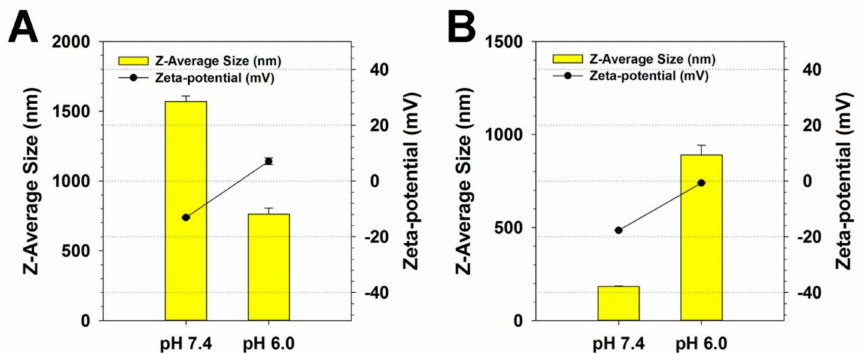
Figure 4. Z-average sizes and zeta-potential values of PKE(PEI-rGO / DOX) nanostructures at pH 7.4 and 6.0. ( A ) PK 5 E 7 (PEI-rGO / DOX) and ( B ) PK 5 E 9 (PEI-rGO / DOX). The PKE polymer coating ratio was set to a weight ratio of 30. Data are shown as the mean ± S.D ( n =